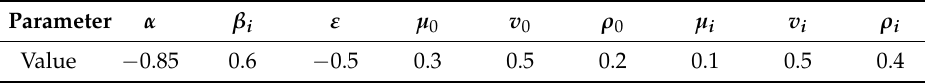
Table 1. Parameter